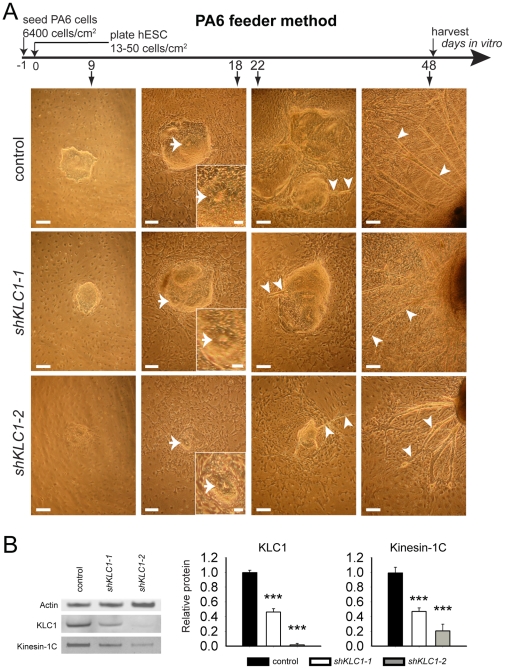
KLC1 and Kinesin-1C subunits are reduced in neural cultures derived from KLC1-suppressed hESC.(A) Control, shKLC1-1 and shKLC1-2 hESC were differentiated for seven weeks using the PA6 feeder method. Representative bright field images of control, shKLC1-1 and shKLC1-2 PA6 feeder cocultures collected at nine, eighteen, twenty-two and forty-eight days after plating. Arrows point to rosettes. Insets show close-ups of indicated rosettes. Arrowheads denote axon-like projections emanating from hESC derived cell clusters. Scale bars: 200 µm for main images, 50 µm for insets. (B) PA6 neural differentiation cultures were harvested after seven weeks in vitro and equal protein from control, shKLC1-1 and shKLC1-2 cultures analyzed by Western blotting for KLC1, Kinesin-1C and Actin. Bar graphs show relative quantification of KLC1 and Kinesin-1C levels relative to Actin. Based on n = 7 control and shKLC1-1; n = 3 shKLC1-2, ***p<0.001 by two-tailed Student's t-test compared to control.